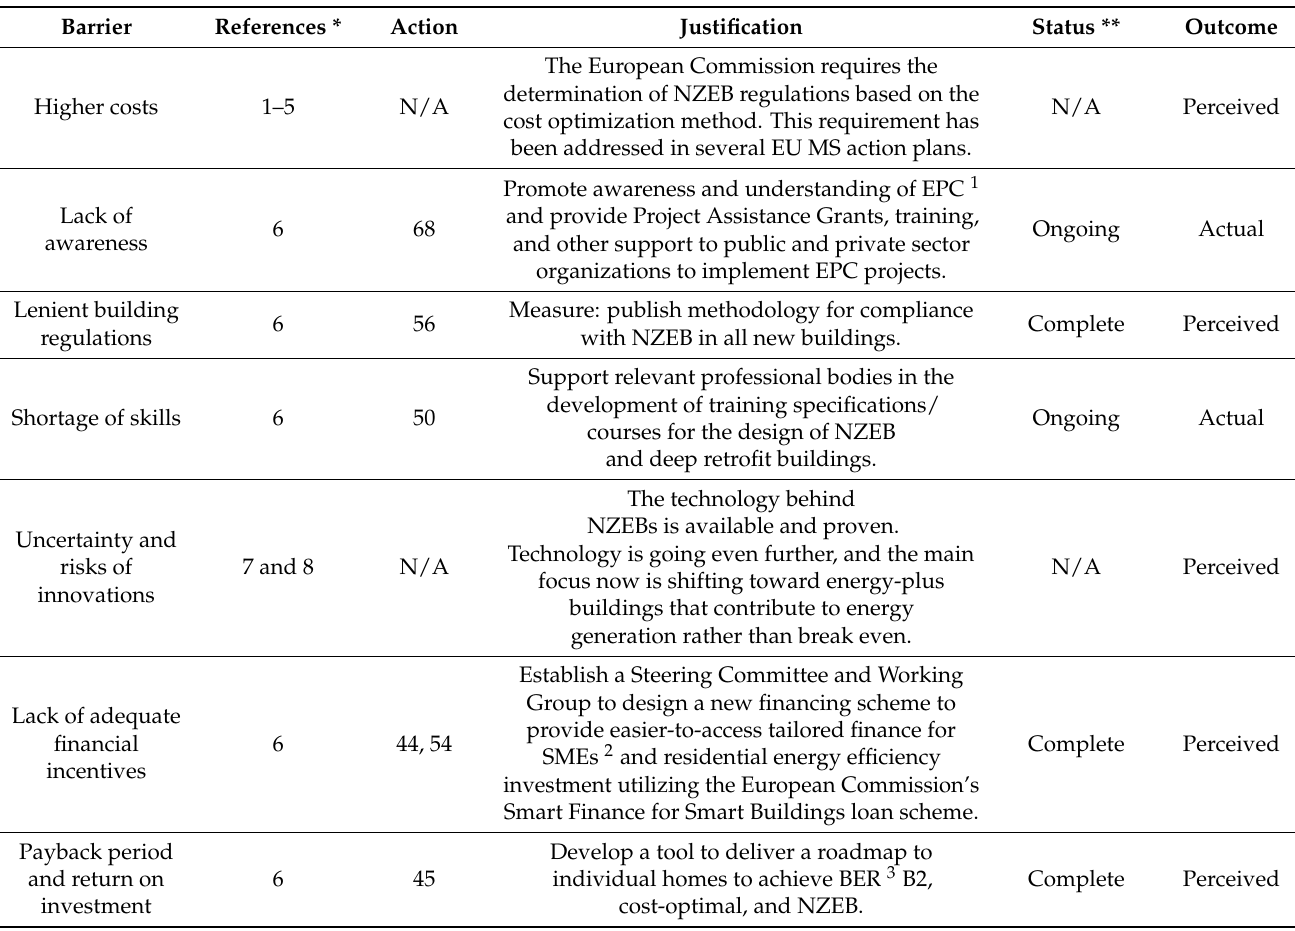
Table 7. Perceived versus actual barriers addressed in Irish policy and other official